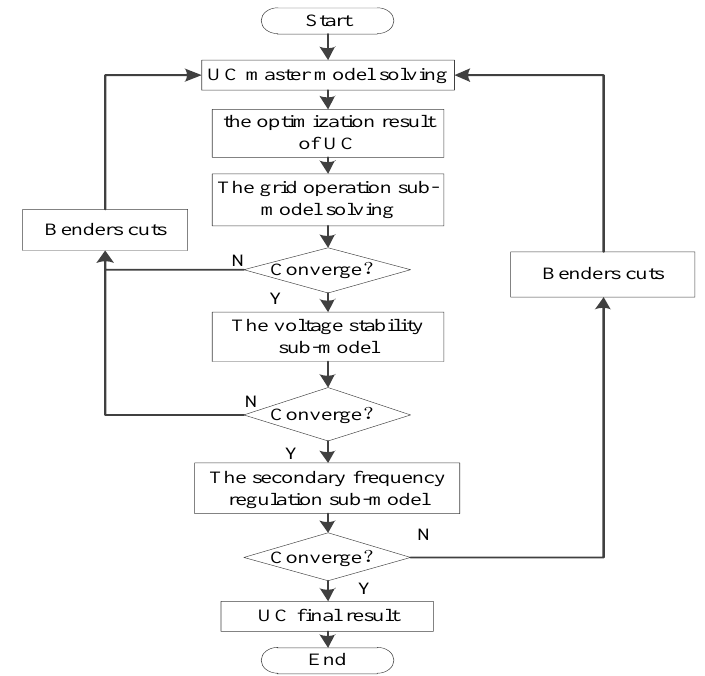
Figure 2. The flow chart of solving the proposed UC model.